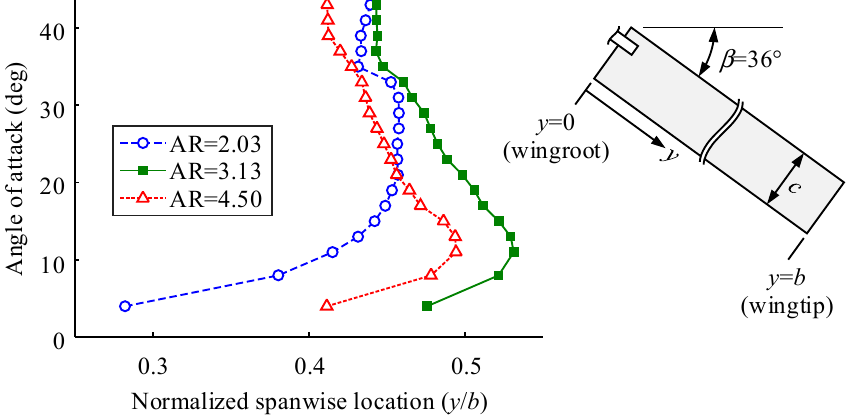
Figure 11. Spanwise location of the center of pressure depending on α .